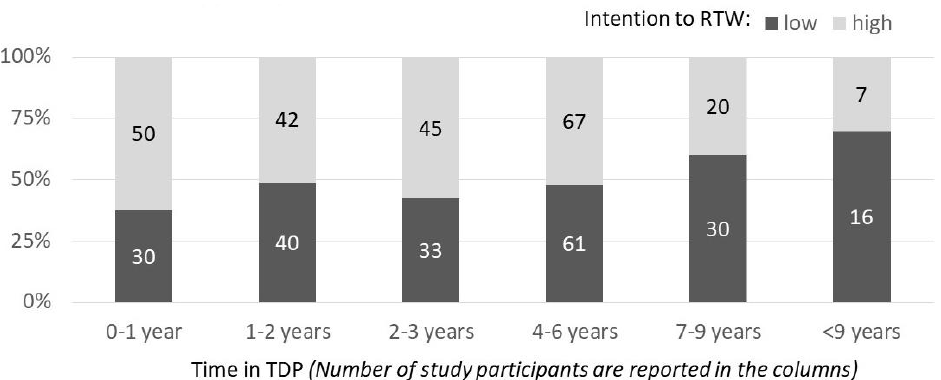
Figure 3. Number of individuals with high (light grey) and low (dark grey) RTW-intention who receive TDP for different time frames at T1. Note . TDP = temporary disability pension; intention to RTW = intention to return to work at T1 dichotomized.